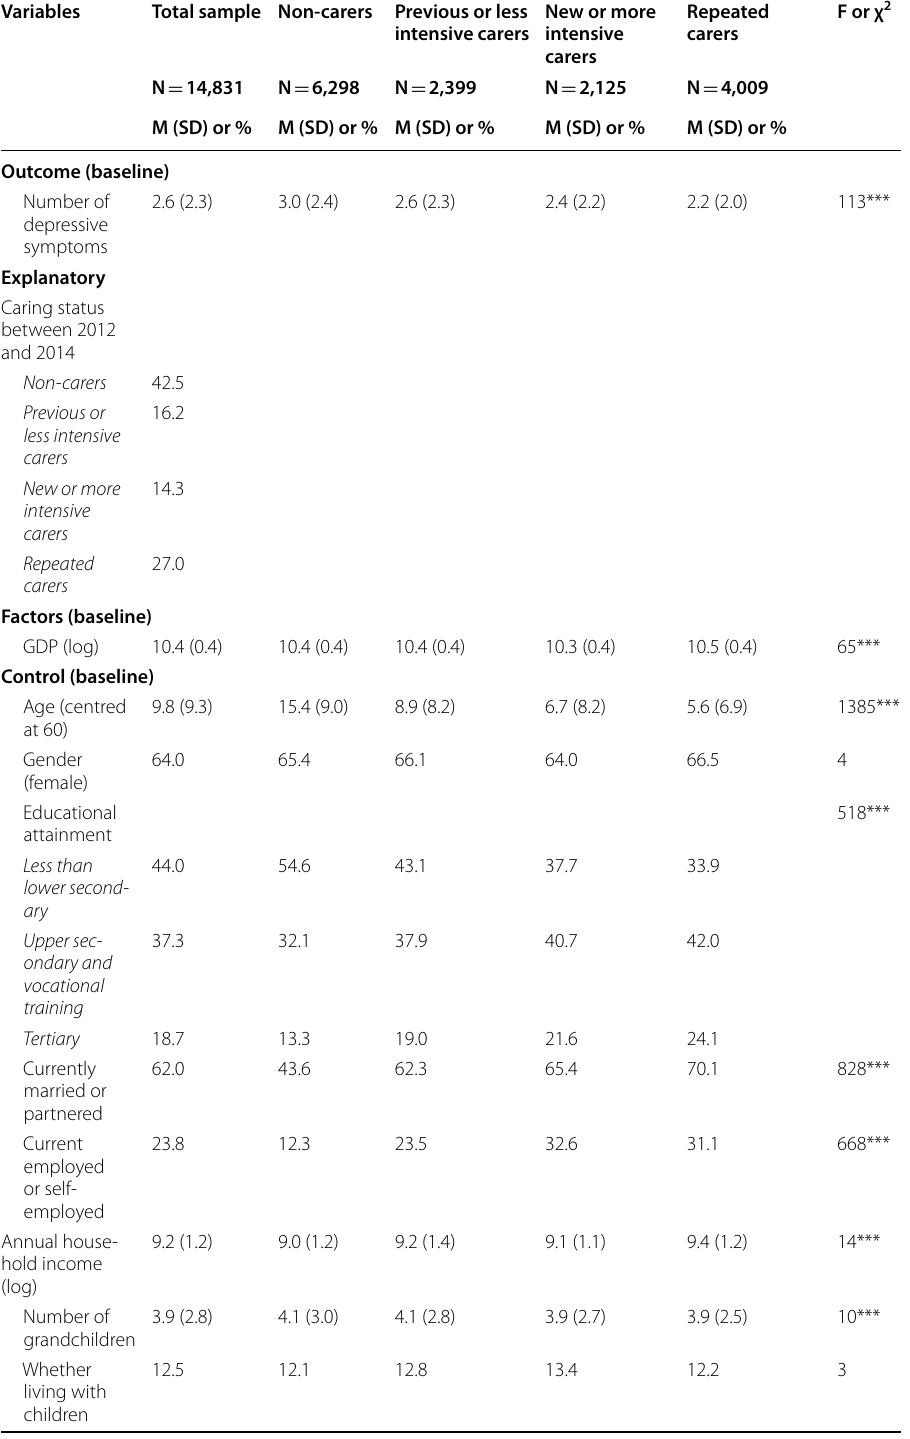
Table 2 Descriptive statistics of the study sample at baseline. Source: Authors’ analysis of the Harmonised SHARE Waves